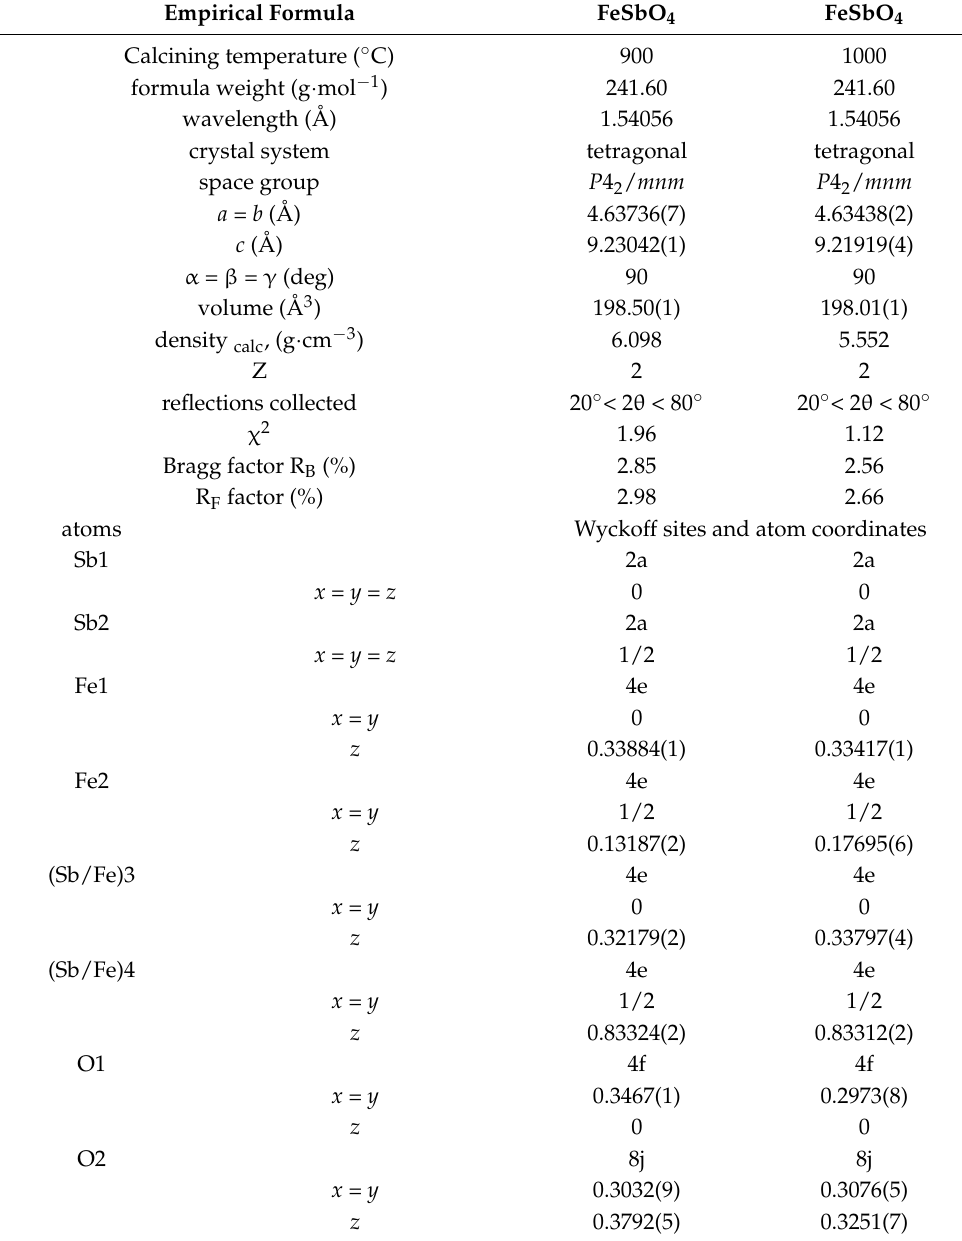
Table 1. Crystal structure data of FeSbO 4 as refined from X-ray powder diffraction data for the powder calcined at 900 and 1000 ◦